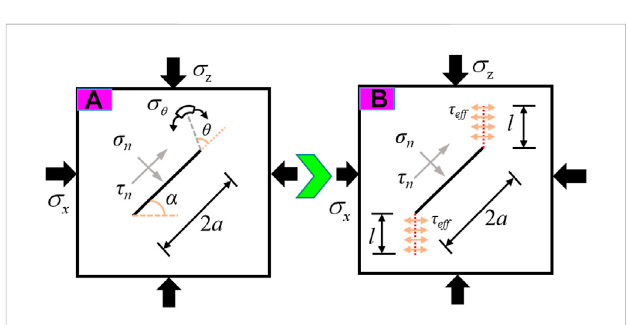
FIGURE 3 Schematic of the initiation and propagation of secondary cracks under the initial stress state: (A) secondary crack initiation and (B) secondary crack